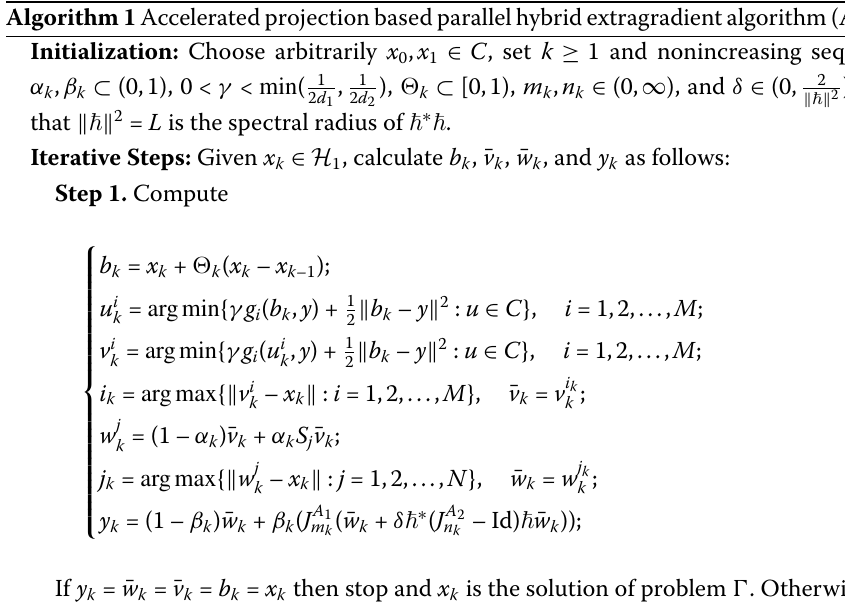
Algorithm 1 Accelerated projection based parallel hybrid extragradient algorithm (Alg.